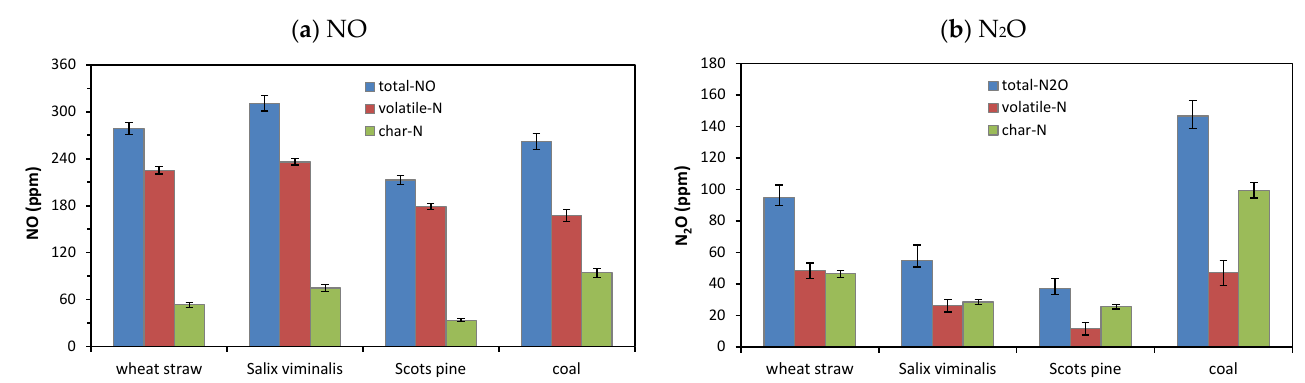
Figure 4. Effect of fuel type on NO ( a ) and N 2 O ( b ) concentrations during air combustion. Vertical bars represent standard deviation.